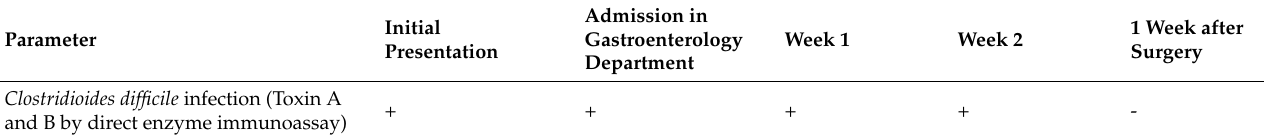
Table 2. Stool tests results.